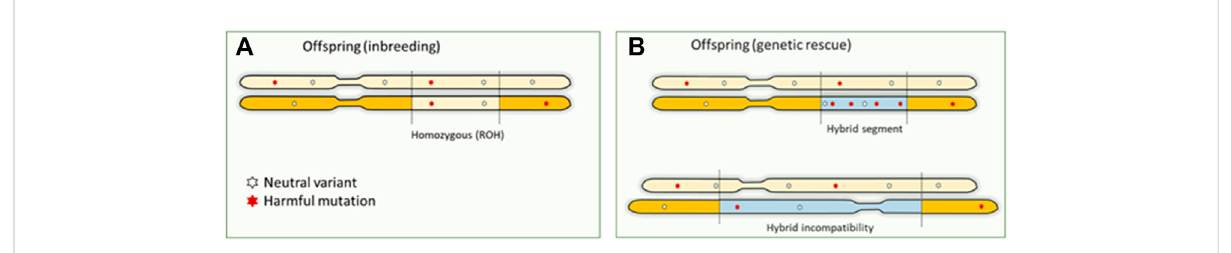
FIGURE 3 Genomic consequences of inbreeding and outbreeding. (A) . Offspring inherit identical DNA twice when parents are related, which means that harmful recessive mutations become homozygous and expressed. This is the primary mechanism causing inbreeding depression. (B) . Outbreeding (genetic rescue) introduces DNA from another source into a population, increasing genetic variation. However, this can also increase the number of harmfulmutationsasamaskedload.Thesemutationscouldbecomeexpressedinhomozygotesinfuturegenerations,asinbreedingcontinues